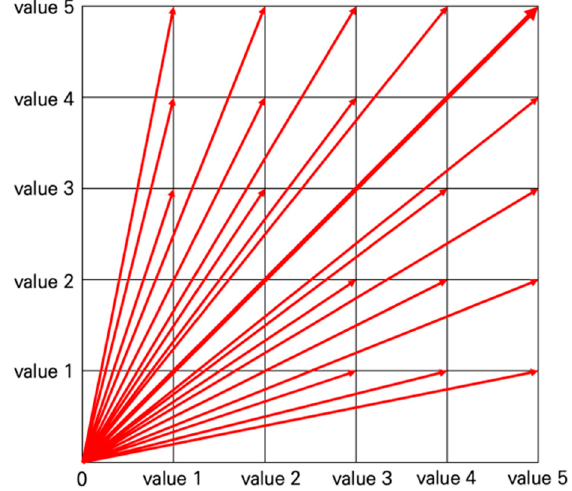
Figure 2. The normalized Euclidean distance.